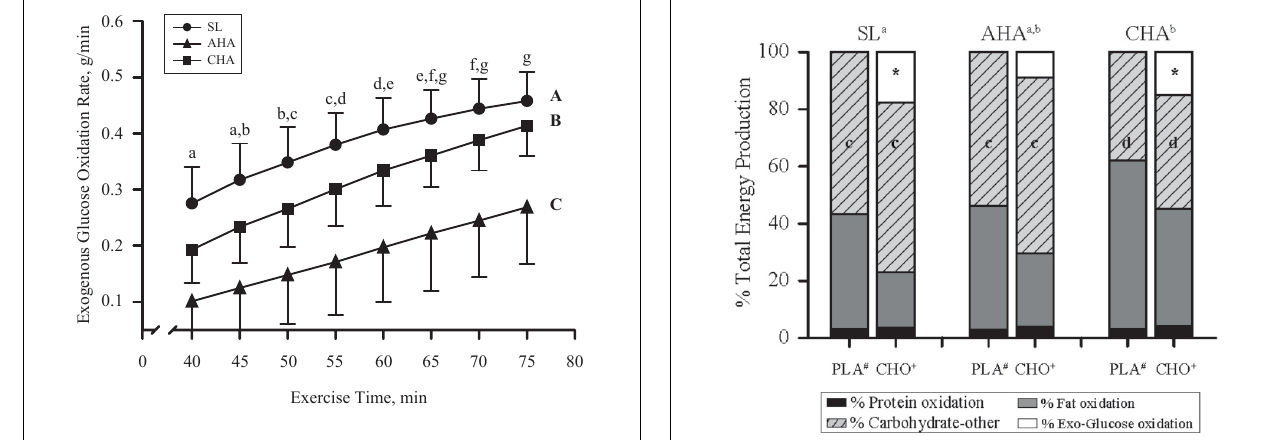
FIGURE 4 | The percentage contribution from oxidation of different energy substrates to total energy production during the last 40 min of 80-min steady-state exercise (treadmill walking) in participants provided 1.8 g/min carbohydrate (CHO, n = 8, 65.25 g fructose + 79.75 g glucose) or non-nutritive placebo (PLA, n = 6) at sea level (SL) and at 4,300 m altitude, within 5–7 h after arrival (acute high-altitude, AHA) and again on the 22nd day of continuous residence at high-altitude (chronic high-altitude, CHA). For PLA, “other” carbohydrate oxidation is entirely endogenous carbohydrate (i.e., glucose provided by muscle and liver glycogen) oxidation, but for CHO, “other” carbohydrate is endogenous carbohydrate oxidation and exogenous fructose oxidation, the latter of which was not captured by the tracer techniques employed in the CHO group. a , b Contribution from oxidation of fat was greater and from carbohydrate (exogenous glucose + other) less at CHA than at SL, but neither differed from AHA (main effect of phase, P < 0.05). ∗ In CHO, contribution of exogenous carbohydrate oxidation was less at AHA than at SL or CHA, which did not differ (main effect of phase, P < 0.05). c , d Contribution from oxidation other carbohydrates at SL and AHA did not differ, but was greater than at CHA. # Contribution of fat oxidation greater in PLA than CHO during all trials (main effect of treatment, P < 0.05). + Contribution of carbohydrate (exogenous glucose + other carbohydrate) oxidation was greater in CHO than PLA during all trials (main effect of treatment, P <